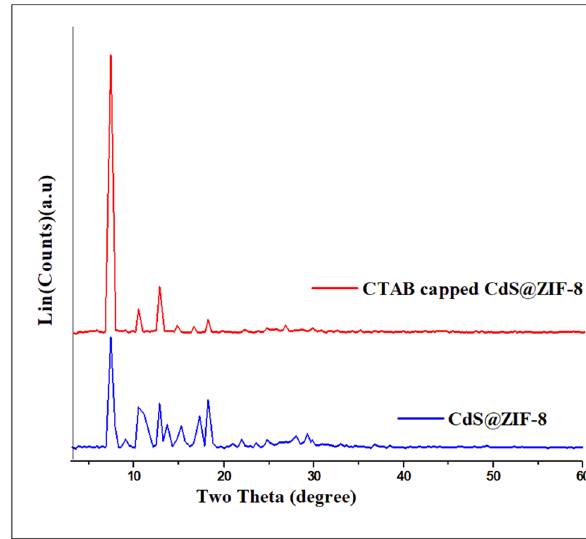
Figure 2. The di ff raction pattern of the as -